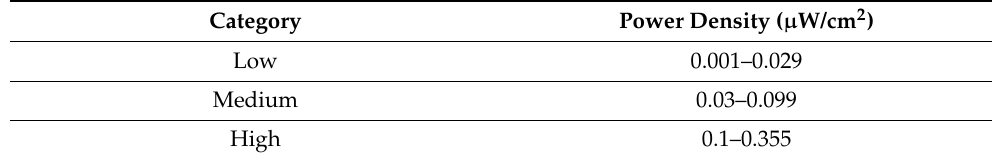
Table 4. Proposed classification based on the power